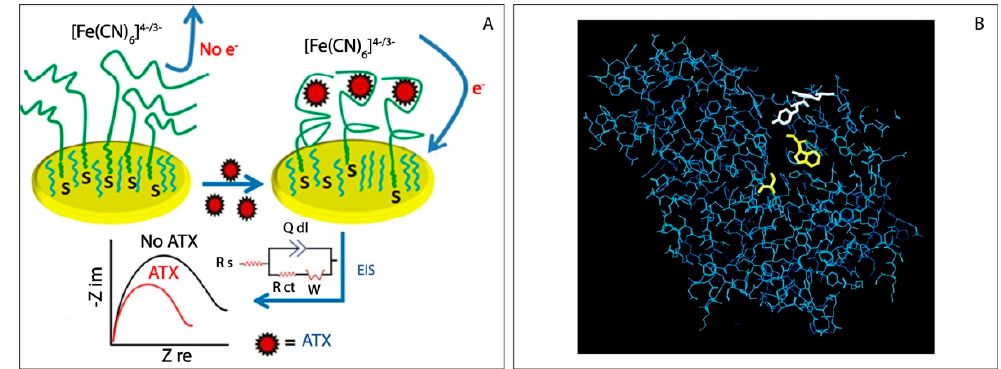
Figure 3. ( A ) Fabrication of the label-free impedimetric aptasensor of anatoxin-a. Without toxin, the negatively charged redox probe is repelled from the surface and its redox reaction is hindered. Upon toxin recognition to the aptasensor, the aptamer induced switching into compact structure, implying more accessible of the electrochemical marker to the surface and the resistance to electron transfer is decreased. Equivalent circuit used to fit the frequency scans along with an impedance spectra (Permission from [53]); ( B ) FIG. 2. Drosophila AChE, it shows the positions of mutations that provided the best sensitivities to anatoxin-a(s) (Tyr71 and Tyr73) in white at the entrance of the active site gorge. Amino acids important for catalysis (Ser238 and Trp83) at the bottom of the active site are shown in yellow (Permission from [55]).